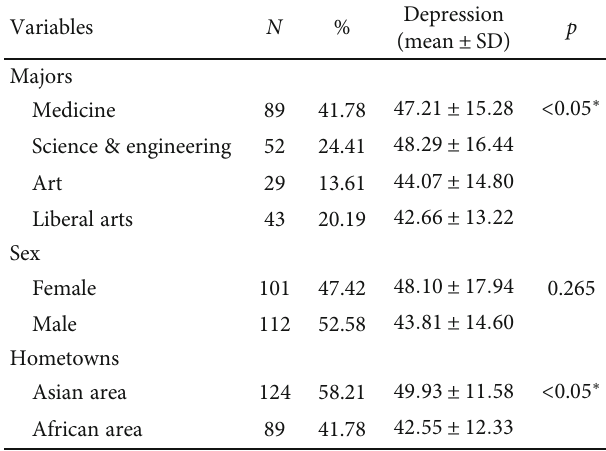
Table 1: Demographic characteristics and depressive behaviors ( N = 213 ).